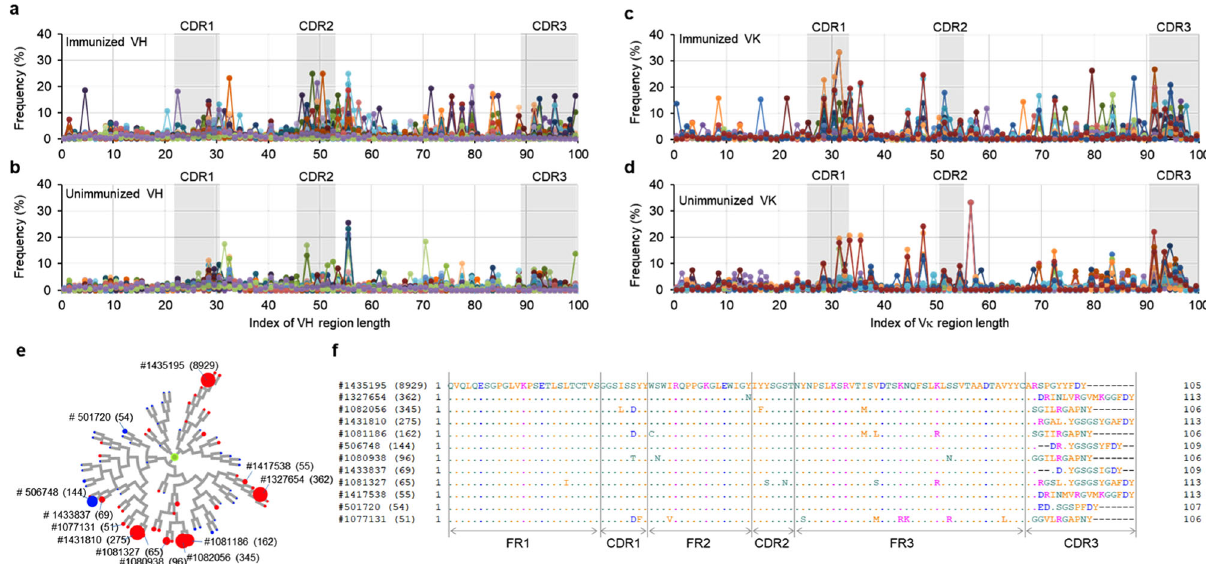
Fig. 4 Somatic hypermutation analysis. The frequency of SHM at every position of the variable region was calculated as described in the Methods section and is represented for VH and VK chains in OVA-immunized TC-mAb mice ( a , b ) and unimmunized TC-mAb mice ( c , d ) (same as Fig. 2). e The phylogenetic tree of the clone type CLH001. The circular dendrograms of the 20 most frequently used clone lineages were over-laid with the number of copies carrying the same CDRH3 sequences. The leaves of circular dendrograms have a maximum of 50 reads; therefore, as the number increases, the circle in the leaves increases. The colour of the circle indicates with (red) or without (blue) immunization in TC-mAb mice. The amino acid sequences of 12 clonotypes containing more than 50 copies in the CLH001 clone lineage. The clonotype numbers and each copy number are also indicated. f Amino acid sequence alignment of the 12 clonotype variable regions of CLH001.